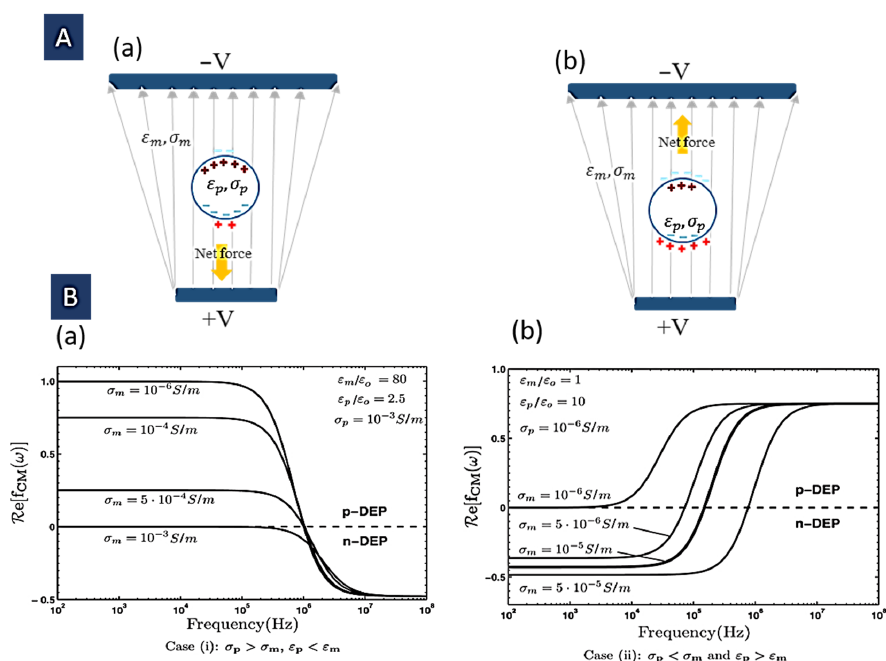
Figure 1. DEP force on an induced dipole in a non-uniform electric field. ( A ): ( a ) Positive DEP (p-DEP); ( b ) Negative DEP (n-DEP). ( B ): ( a ) DEP spectra of a dielectric particle with σ p > σ m , ε p < ε m ; ( b ) DEP spectra of a dielectric particle with σ p < σ m , ε p > ε m (Reprinted with permission from [14]. Copyright 2011, John Wiley and